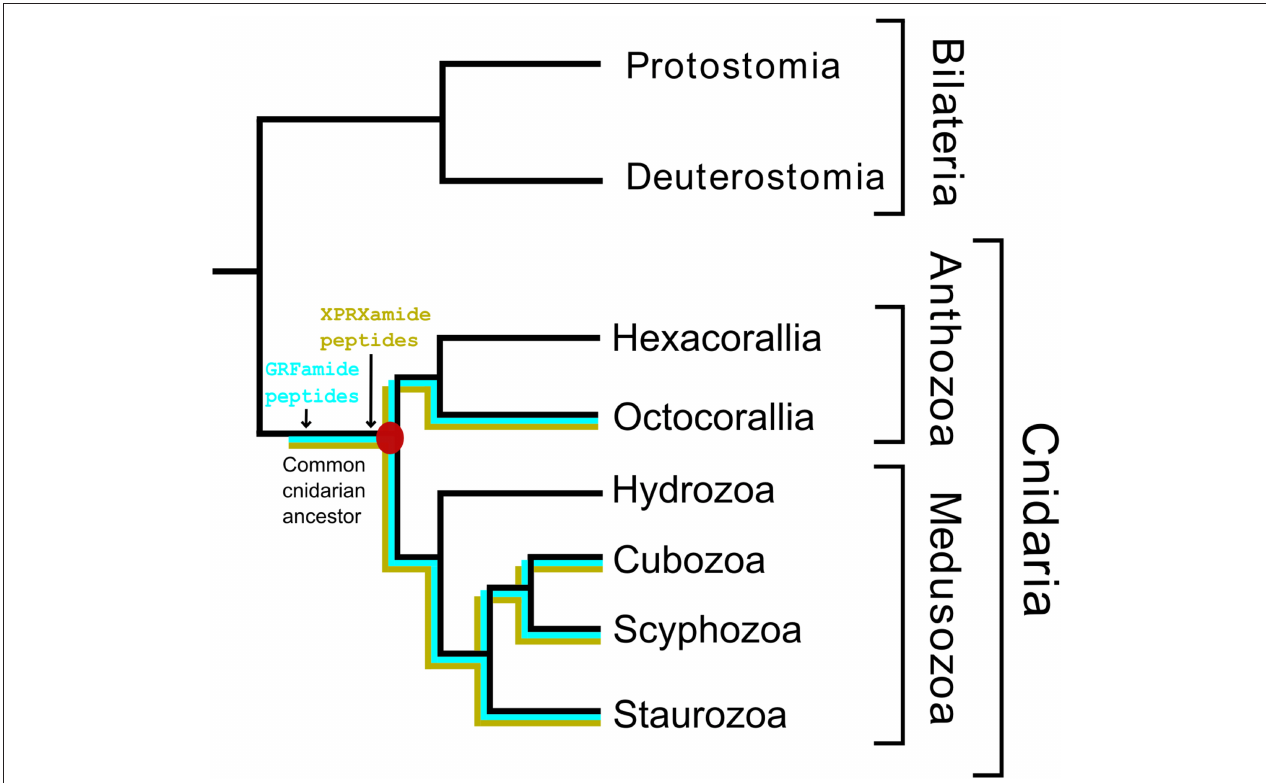
FIGURE 5 | A schematic drawing illustrating the evolution of some neuropeptides in Cnidaria. This figure has the same structure as Figure 1 . It shows that the GRFamide peptides (highlighted in blue) and the X 1 PRX 2 amide peptides (highlighted in yellow) originated before or in the common cnidarian ancestor (indicated by a filled red